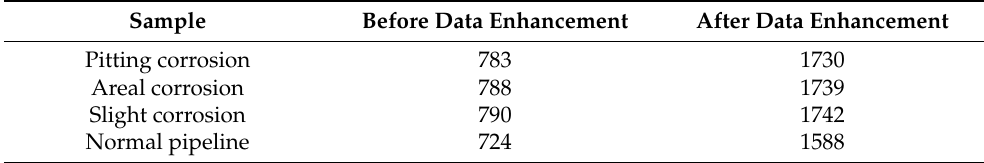
Table 1. Sample size before and after